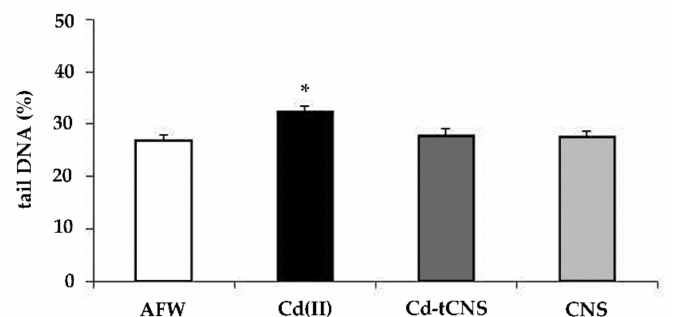
Figure 3. DNA primary damage (% tail DNA) in zebra mussel hemocytes after 48 h of exposure to the following experimental groups: AFW (control); Cd(II) (0.05 mg L − 1 of CdCl 2 in AFW); Cd-t CNS (CdCl 2 0.05 mg L − 1 contaminated AFW treated with CNS); CNS (AFW treated with only CNS). Results are shown as mean ± SE. (*) indicates significant di ff erences respect to the control group (AFW) ( p <